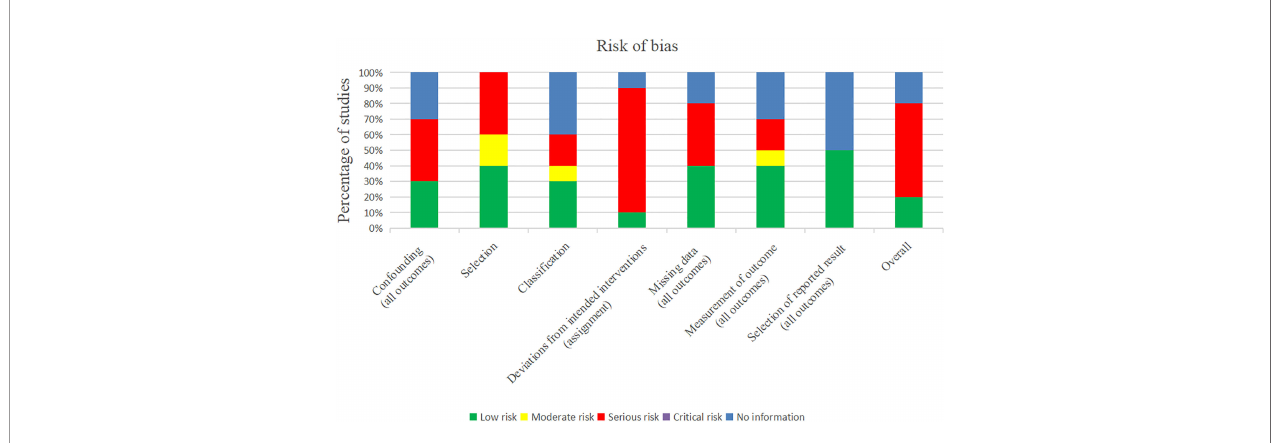
FIGURE 2 | Risk of bias.